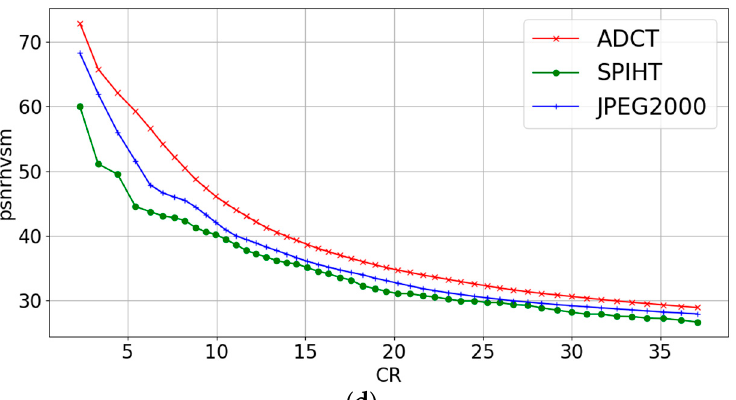
Figure 3. Dependences of Peak signal-to-noise ratio (PSNR) ( a , b ) and Peak Signal-to-Noise Ratio using Human Visual System and Masking (PSNR-HVS-M) ( c , d ) on compression ratio (CR) for complex structure ( a , c ) and simple structure ( b , d ) images.